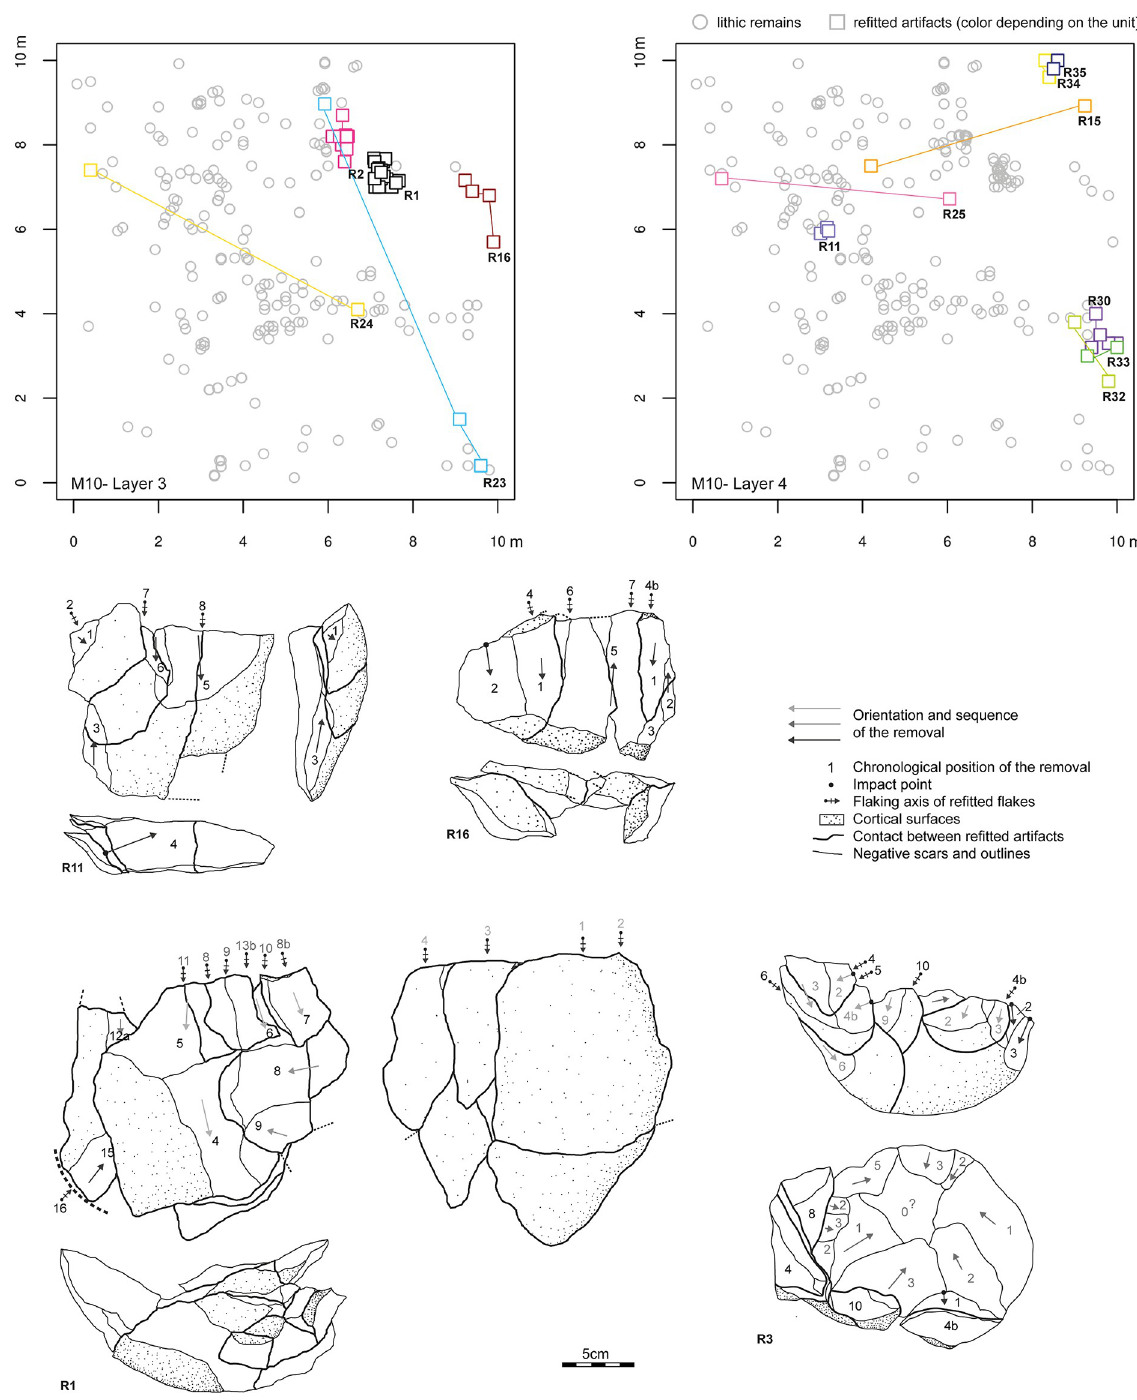
Fig 5. Lithic refit units R1, R3, R11 and R16 and planimetric mapping of the refittings of the sector M10 Layer 3 and Layer 4.